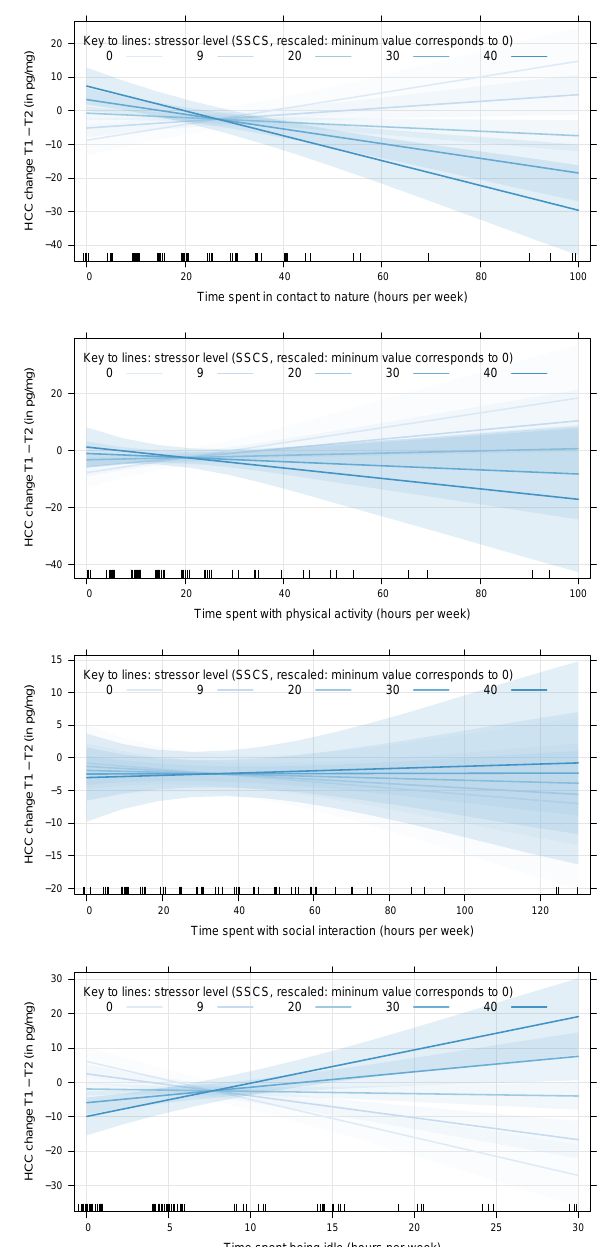
Figure 1. Interaction plots for the combined effects of stressor levels and characteristics of recreational activities during summer on the change in hair cortisol concentration (HCC, in pg/mg; differences between spring and fall measurements; higher values denote a more positive state, i.e., they correspond to a higher reduction of HCC). Only the interaction effects between time spent in nature and stressor level (upper panel) and between idleness and stressor level (lower panel) were statistically significant (see Table